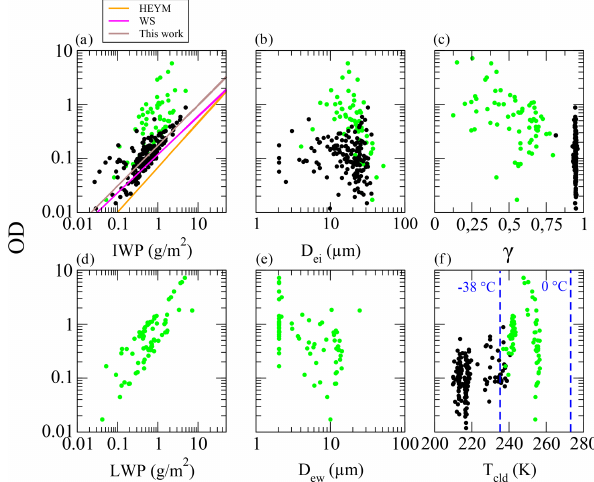
Figure 3. (a, d) The scatter plot of OD vs. the ice water path (IWP) and liquid water path (LWP) for ice (black) and mixed (green) clouds. The solid brown, orange and magenta lines represent the power-law fit obtained in this work and in the previous works of Heymsfield et al. (2003) and Wang and Sassen (2002), denoted as HEYM and WS, respectively. (b, e) The OD vs. effective diameters of ice crystals ( D ei ) and water droplets ( D ew ). (c, f) The same scat- ter plot of OD vs. the ice fraction ( γ ) and cloud temperature ( T cld